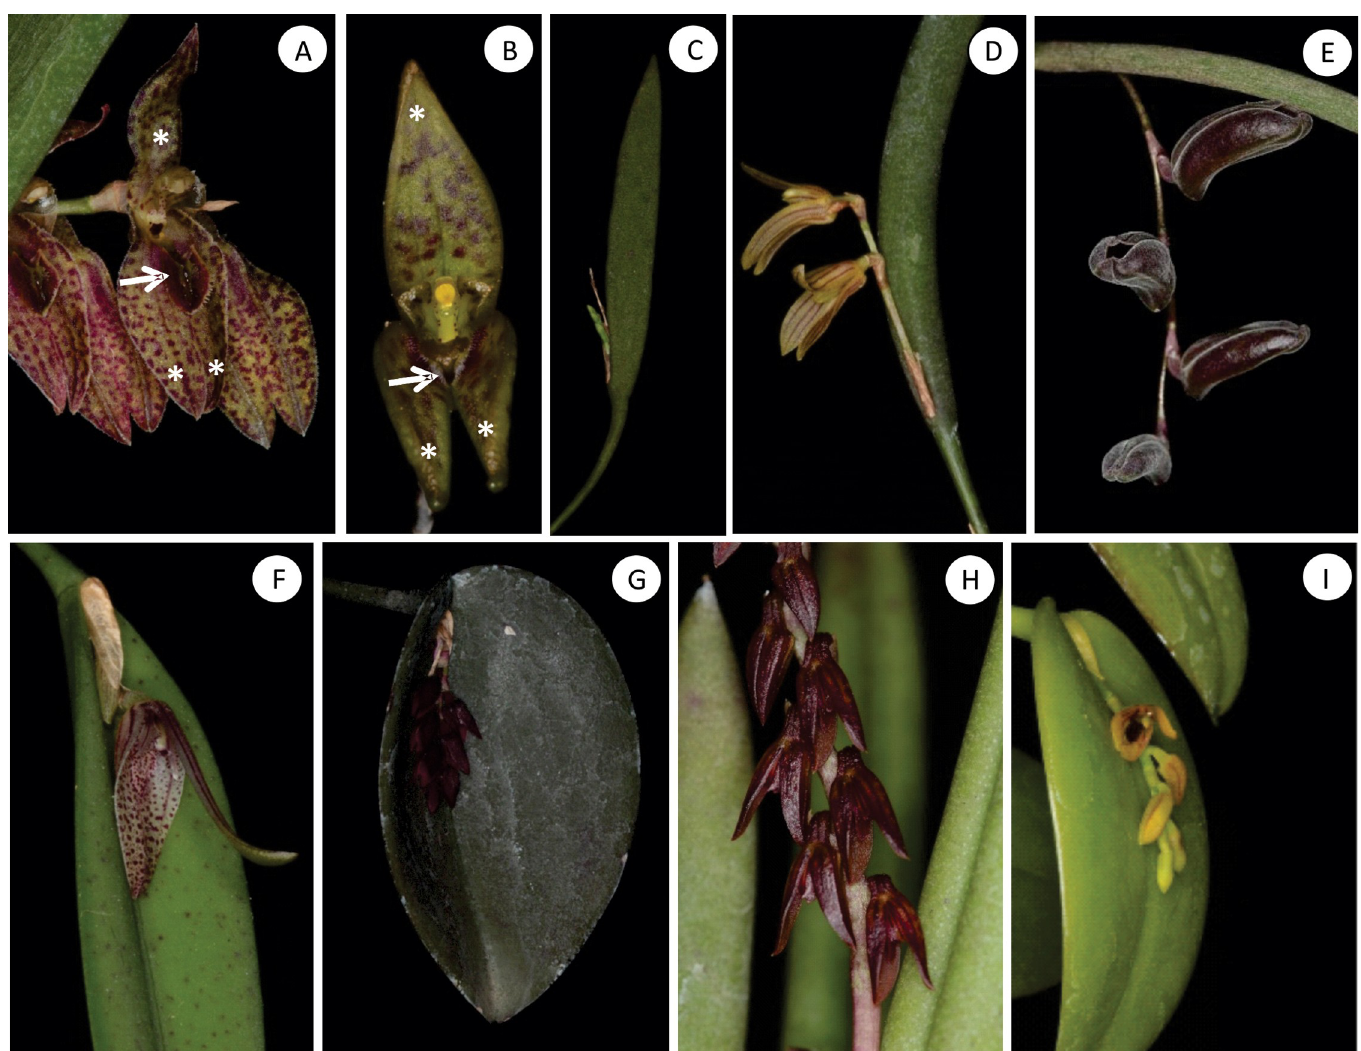
Fig 1. Morphological aspects of sampled Acianthera . Acianthera section Pleurobotryae (A-E), Acianthera section Acianthera (F), Acianthera section Sicariae (G), Acianthera section Tricarinatae (H), Acianthera section Sulcatae (I). (A) Acianthera crepiniana flower showing sepals ( � ) and labellum (arrow). (B) Acianthera hatschbachii flower showing sepals ( � ) and labellum (arrow). (C) Acianthera crepiniana vegetative organs, ramicaul and leaf. (D) Acianthera mantiquyrana . (E) Acianthera atropurpurea . (F) Acianthera gracilisepala . (G) Acianthera prolifera . (H) Acianthera teres . (I) Acianthera luteola